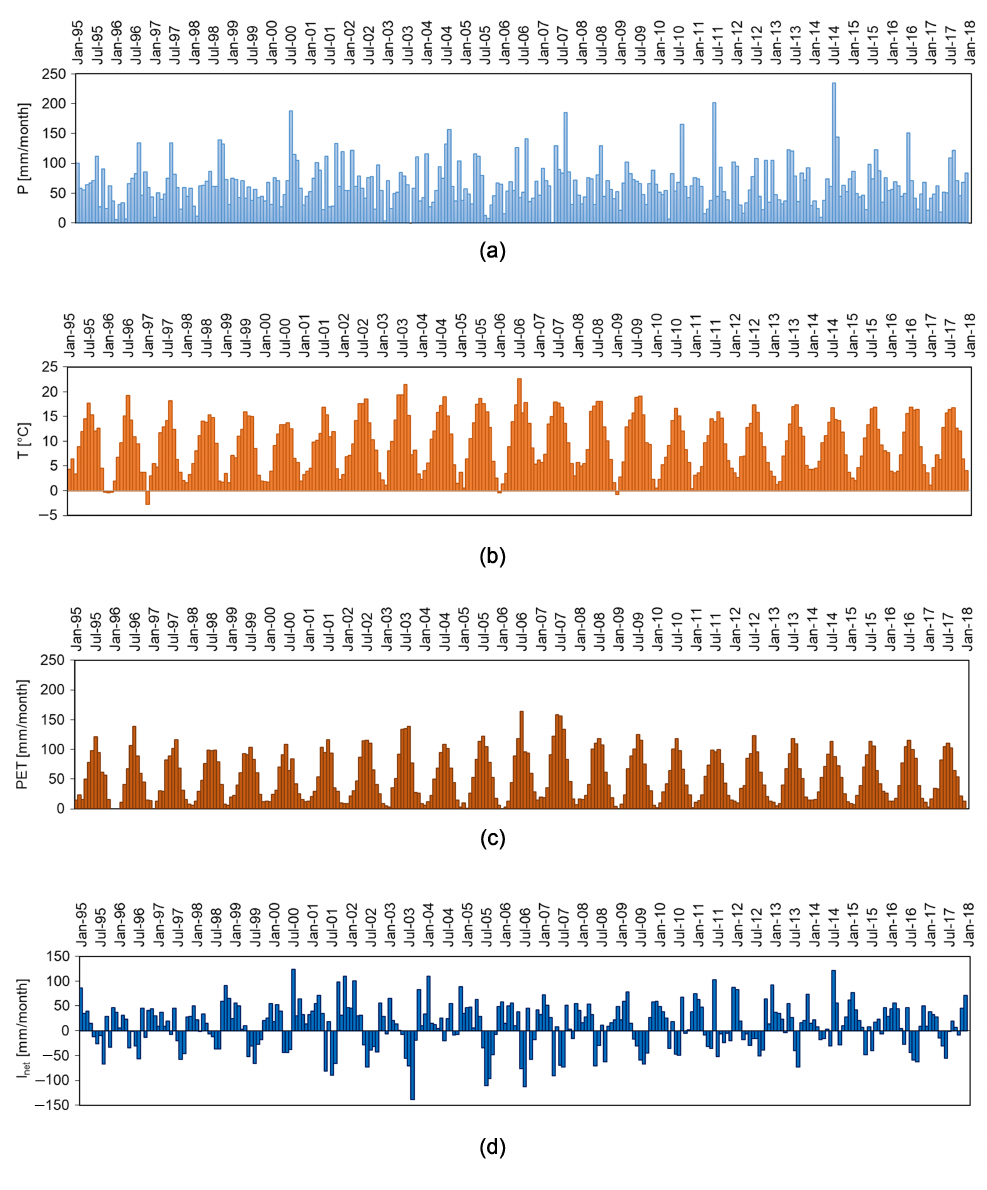
Figure 4. ( a ) Monthly precipitation, ( b ) temperature, ( c ) potential evapotranspiration, and ( d ) net infiltration for the Dollendorfer Hardt test site based on the data of Königswinter-Heiderhof station from